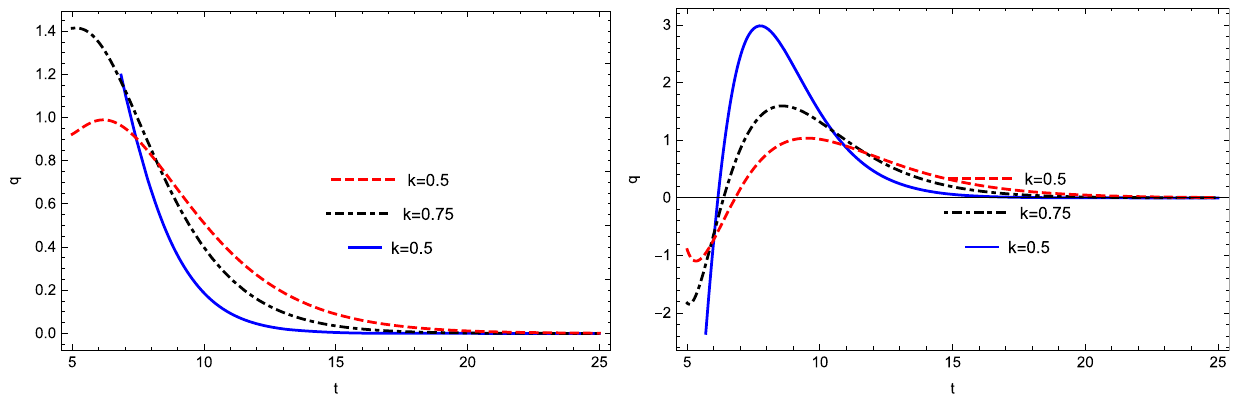
Fig. 18 Plot of q verses t for n = − 2 . 8 and n = − 3 . 8 for Bianchi type-V